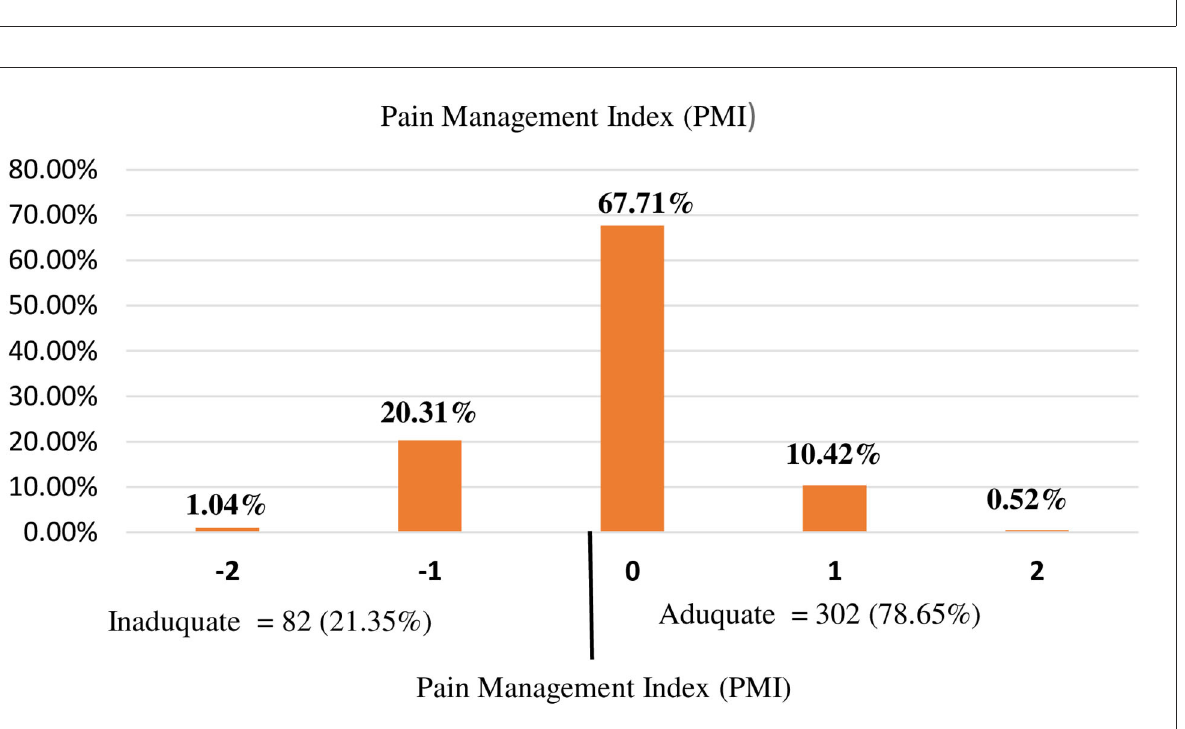
FIGURE2 The proportion of pain management index